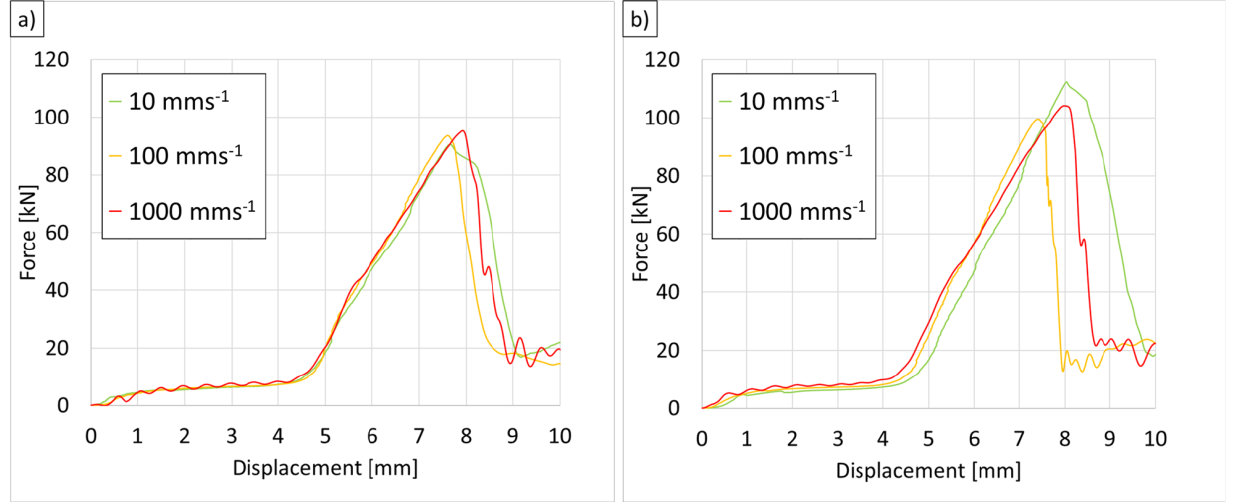
Figure 11. Force vs. displacement curves of experiments with different impact velocities and ( a ) 40% SoC and ( b ) 100% SoC.